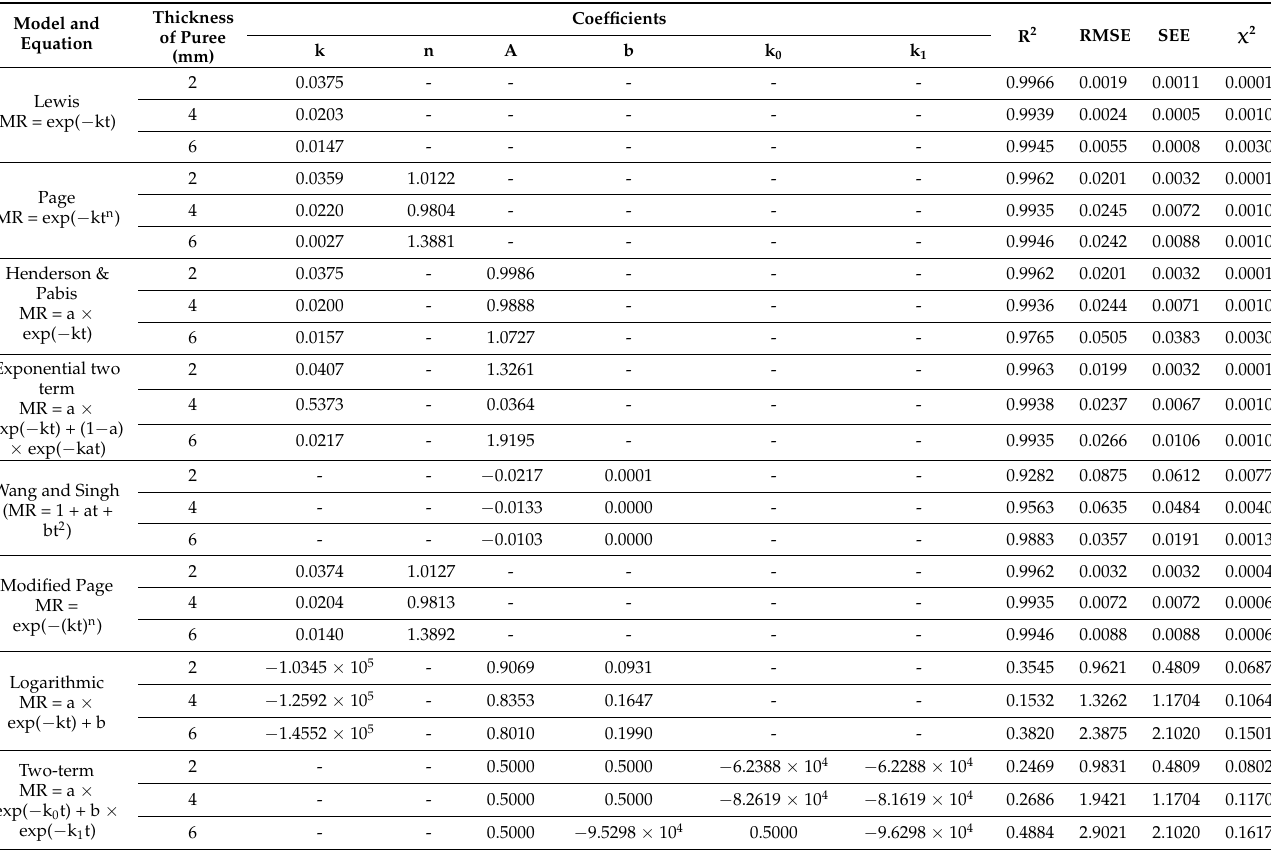
Table 1. Mathematical models used to predict the moisture ratio values and regression coefficients with statistical parameters of RW-dried samples.